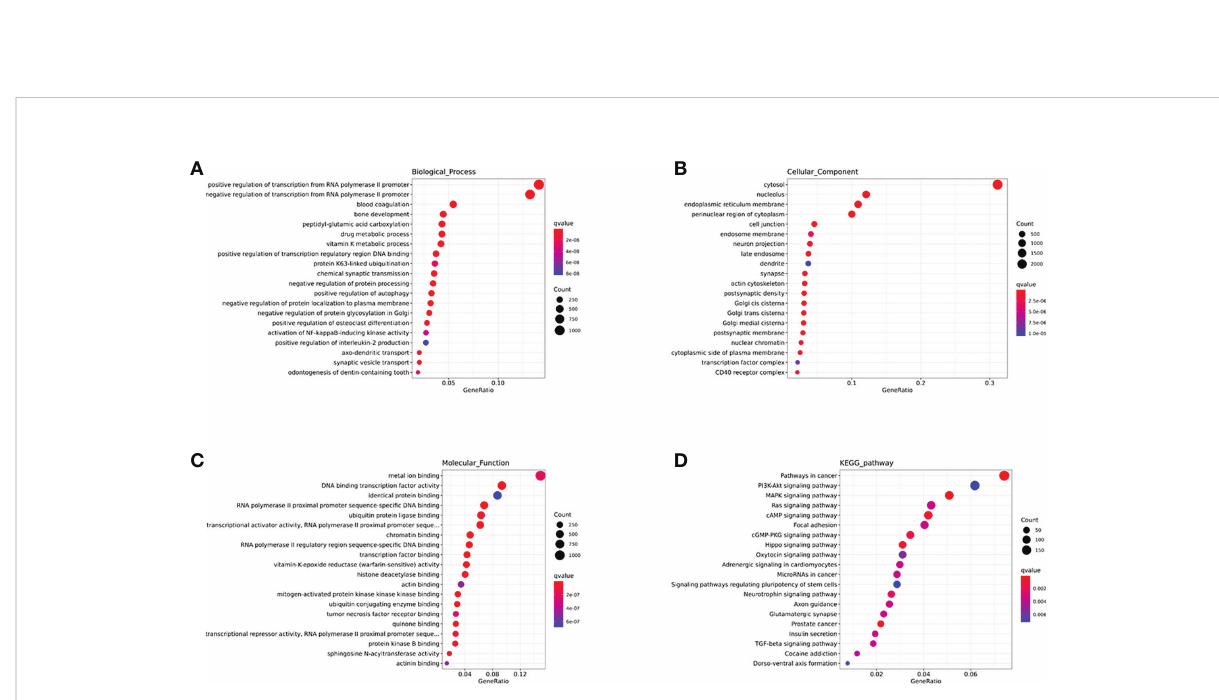
FIGURE 6 The GO and KEGG enrichment analysis interpretation for the functions of the brown module. (A-C) The GO terms interpretation for the functions of these 208 differential miRNAs. (D) The KEGG terms interpretation for the functions of these 208 differential